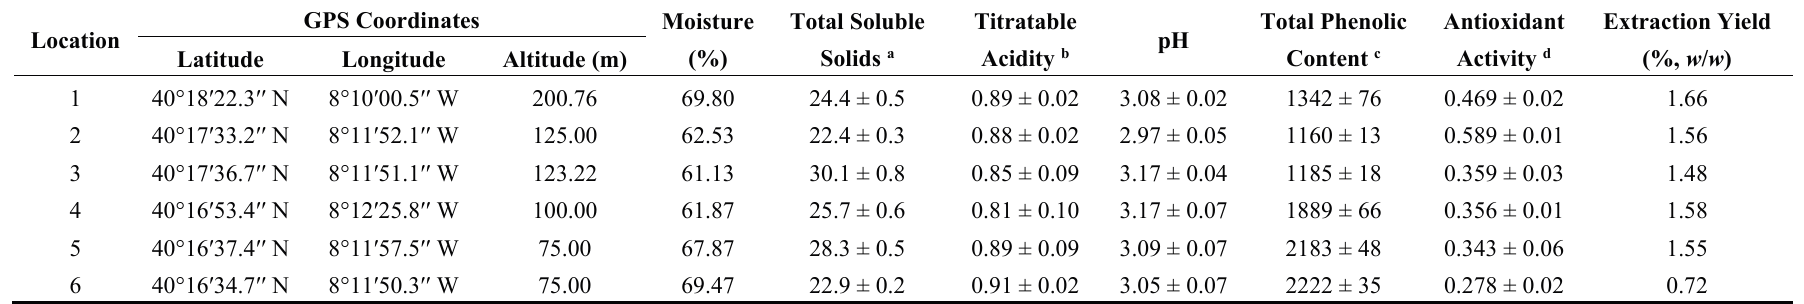
Table 1. Geographical (GPS) coordinates, general chemical characterization and dichloromethane extraction yields of A. unedo berries harvested from six locations in Penacova (center of